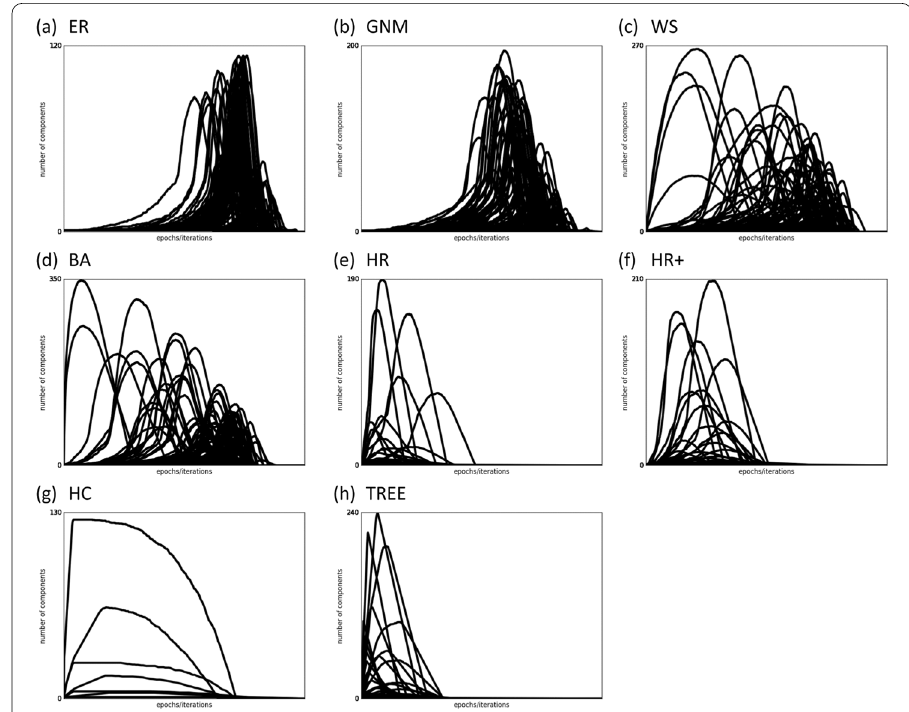
Fig. 8 The response of the eight graph models to the betweenness based node selection failure model method. Each response is plotted with the y-axis showing the number of components and the x-axis showing the % of nodes removed from the graph, and thus the most robust graphs would show a small number of components, with any increase shown to the right of plots as x tends away from 0. Plots ( e ), ( f ) and ( h ) show a lack of robustness to the node failures with peaks in component numbers to the very left of the plots, whereas the peaks are much further to the right in plots ( a )–( d ) indicating a slower rate of failure/ fragmentation of the graphs. Plot ( g ) shows a unique behaviour of immediate fragmentation, but appears to then show some resilience to further node